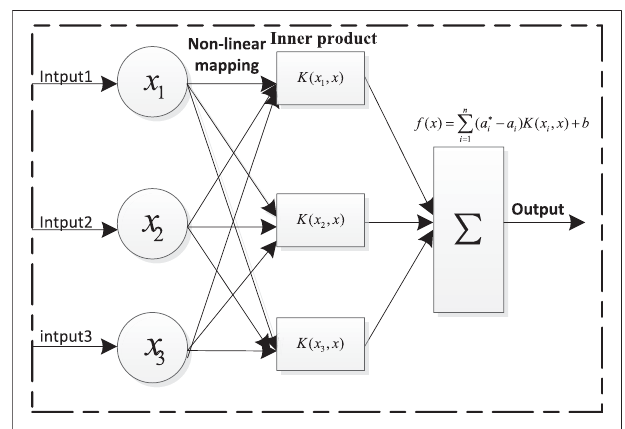
FIGURE 1 | Support vector machine model for battery SOC/SOH